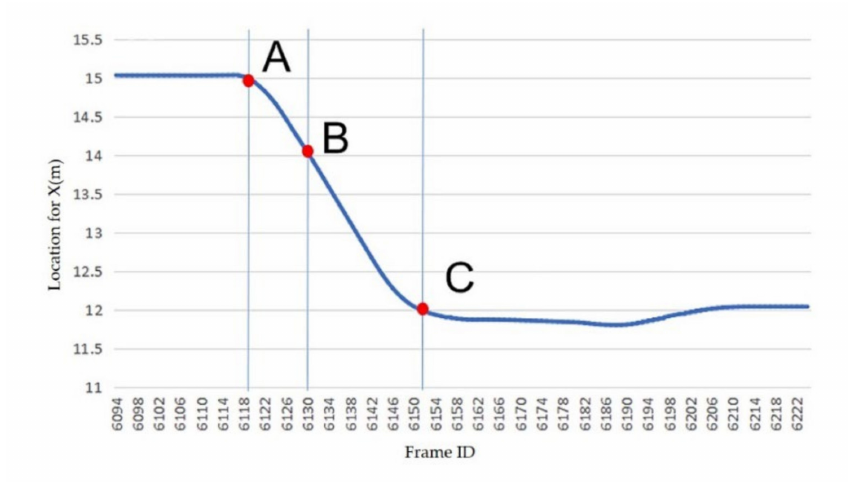
Figure 2. Key time nodes for lane-changing behavior